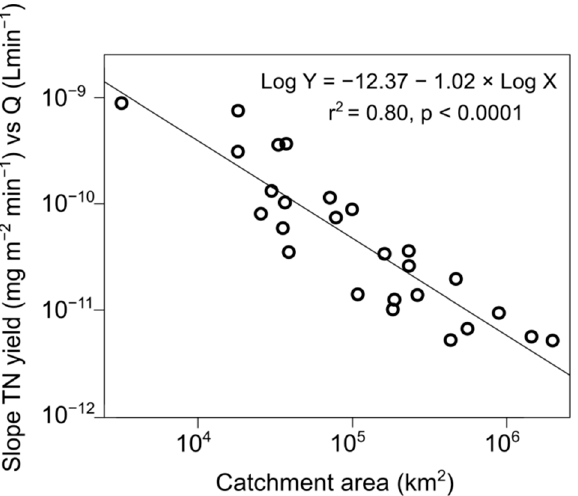
Figure 3. TN yield rates (i.e., the slopes of TN yield—Q regression) versus catchment size.